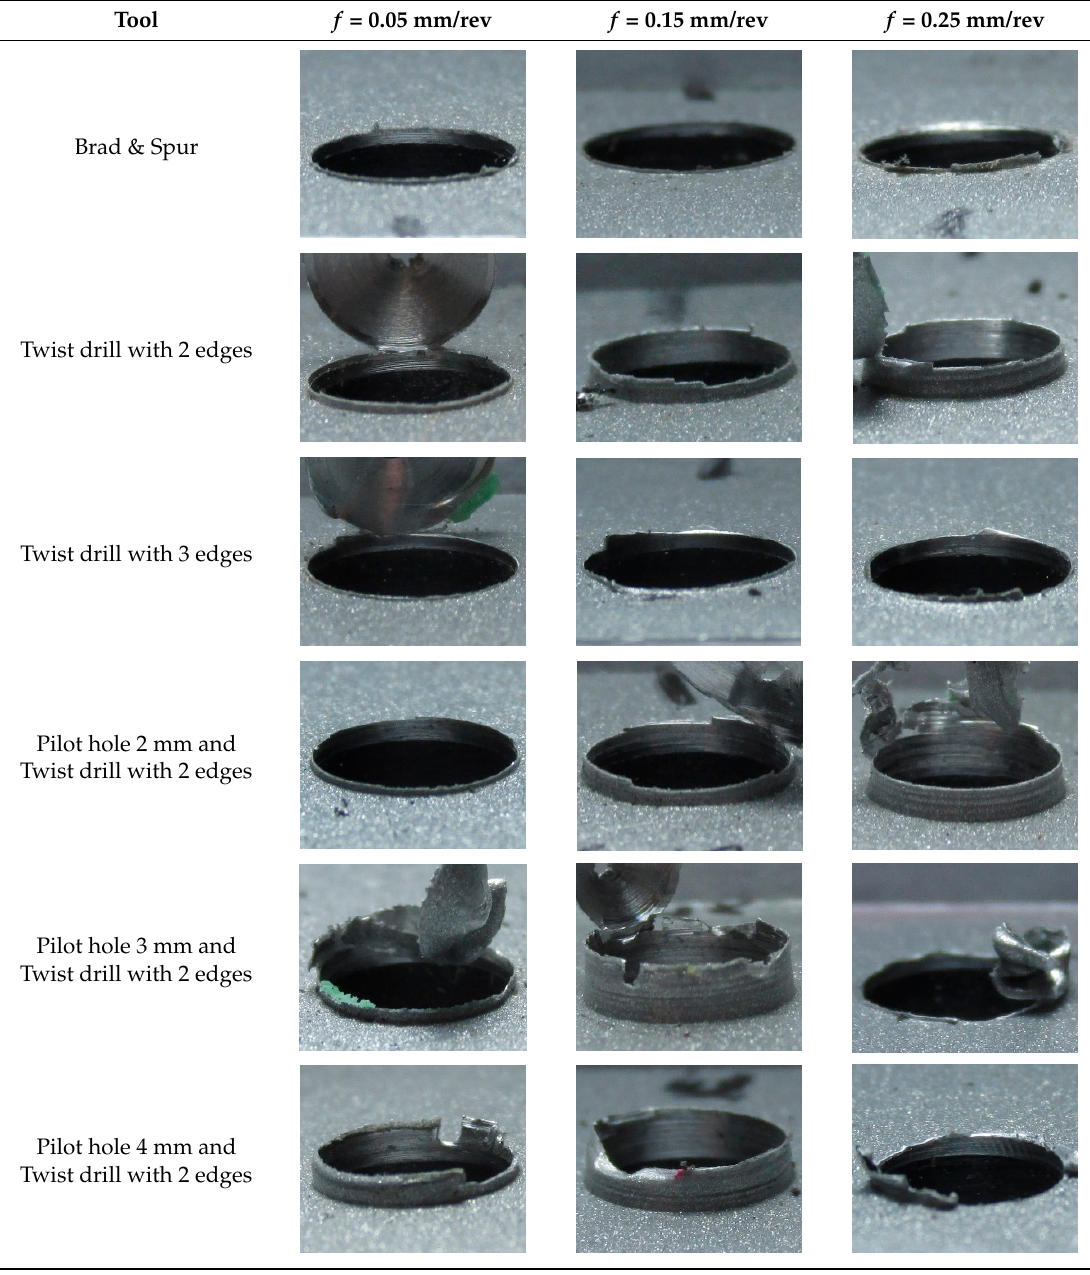
Table 5. Burrs generated after drilling at a cutting speed of 48 m/min.